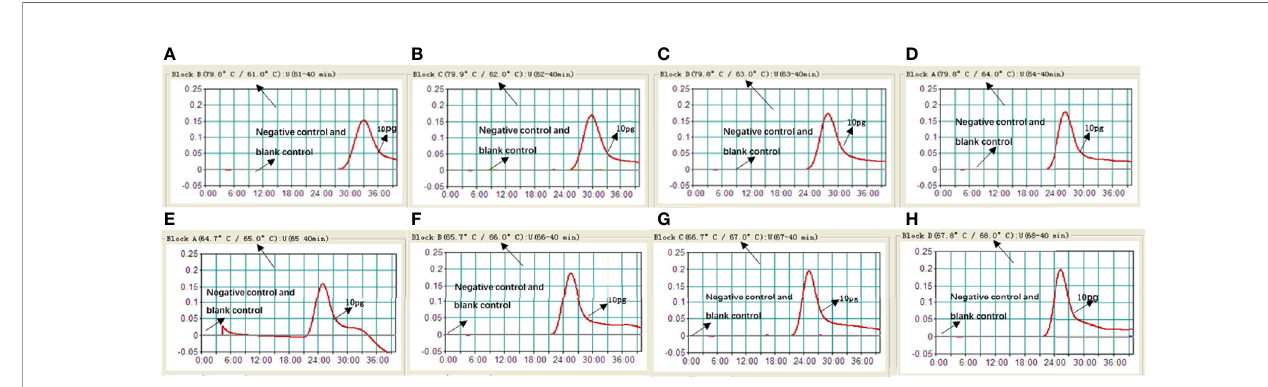
FIGURE 3 | Optimizing the reaction temperature of MCDA-LFB assay. We used real-time turbidity detection, and the kinetic curves at different temperatures to analyse the reactions of the MCDA assay. The threshold value was 0.1 and the turbidity of >0.1 was considered to be positive. Eight kinetic graphs (A – H) were generated at various temperatures (61 – 68°C, 1°C intervals) with target pathogens DNA at the level of 10 pg per reaction.